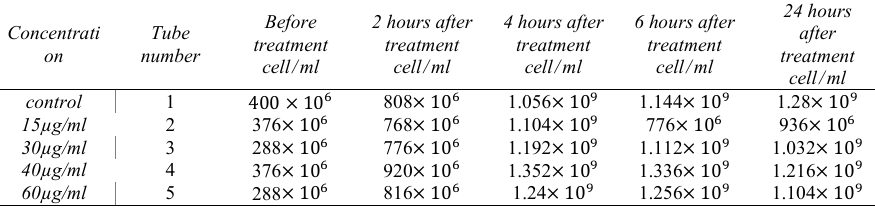
Table 4: Mean optical density reflecting antimicrobial activity exhibited by CuO NPs